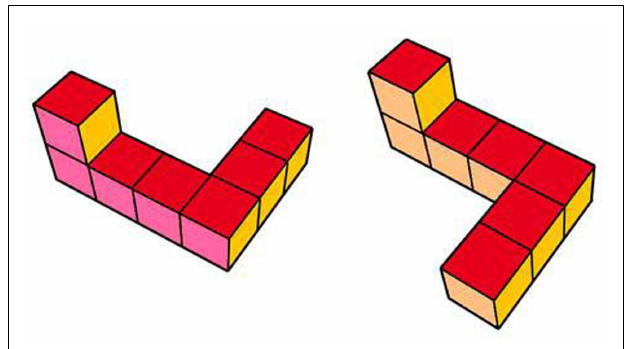
FIGURE 1 | Images of the simplified Shepard–Metzler objects, the L-object and its mirror image, the R-object, pictured on the left and right,